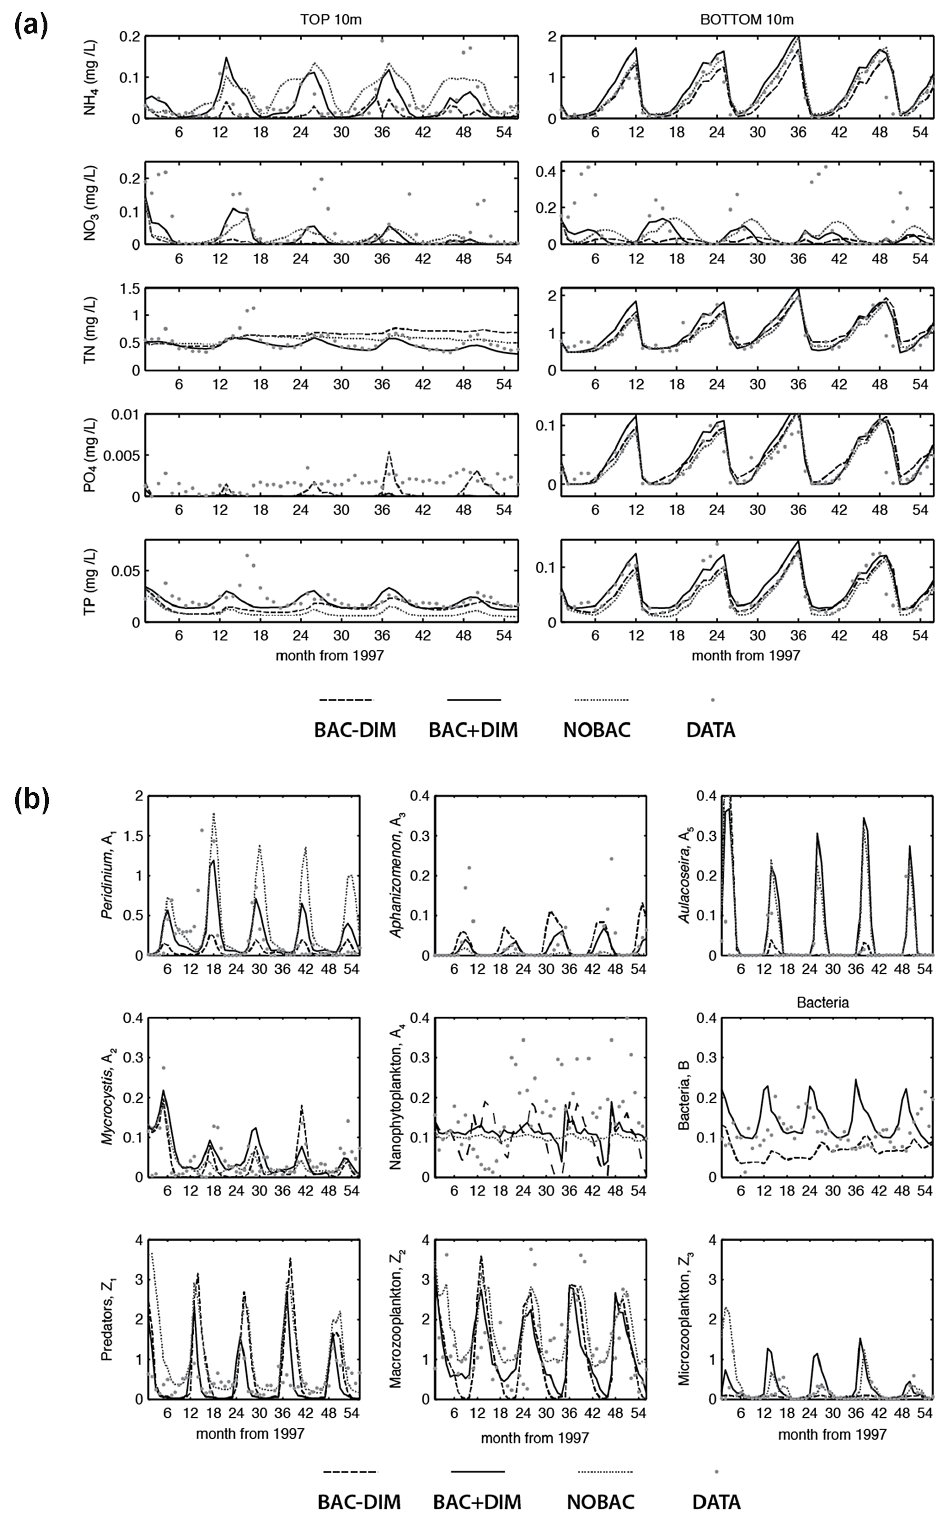
Figure 2. Comparison of model simulations for (a) nutrient variables in the surface 10m (left) and the bottom 10m (right) of the water column (mgL − 1 ), and (b) for the nine simulated biotic groups (mgCL − 1 for A 1–5 and B , and mgCm − 2 for Z 1–3 ). Data represents the monthly mean of samples collected over these